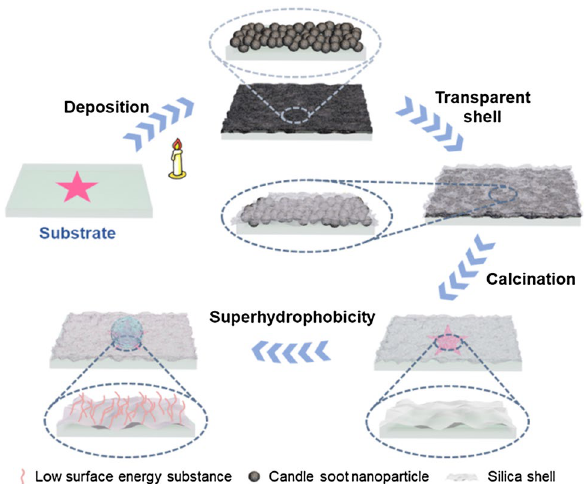
Figure 1. Schematic illustration of preparation and properties of the transparent and robust superhydrophobic